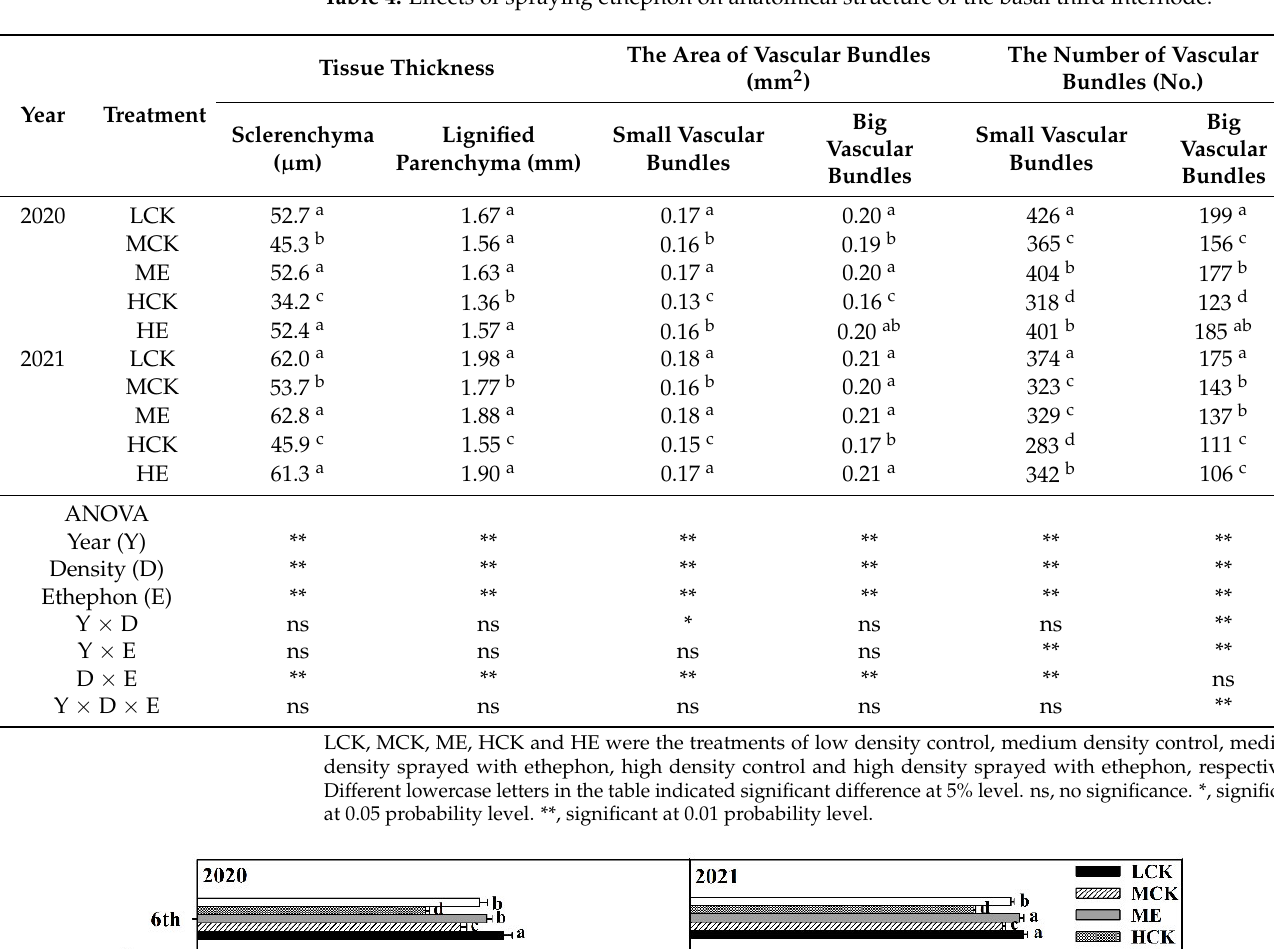
Table 4. Effects of spraying ethephon on anatomical structure of the basal third internode.